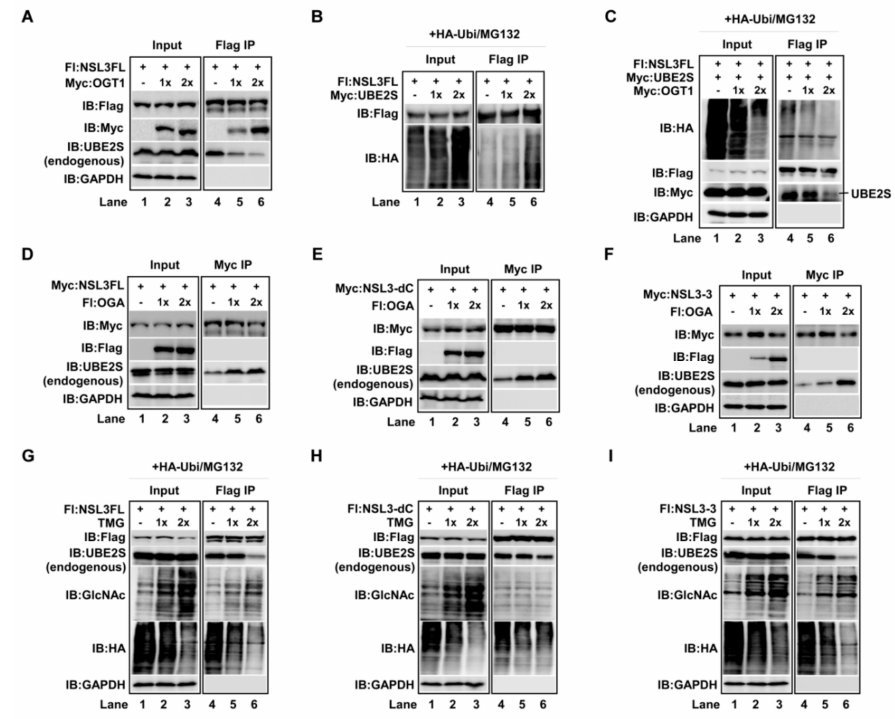
Figure 3. O -GlcNAcylation of NSL3 by OGT1 was tightly associated with UBE2S-mediated ubiquitin-degradation pathway. “ + , − ” in figures caption means with or without. ( A ) Dose-dependent inhibition of OGT1 on the interaction between endogenous UBE2S and NSL3: increasing amounts of Myc-OGT1 were co-transfected with Flag-NSL3 in 293T cells. Forty-eight hours after transfection, anti-Flag eluates were analyzed by WB with anti-UBE2S antibody. ( B ) Increased ubiquitin-degradation levels of NSL3 in the presence of UBE2S: degradation status of exogenous NSL3 was tested after Flag IP using anti-HA antibody. ( C ) Suppressed UBE2S-mediated degradation of NSL3 by OGT1: UBE2S mediated degradation of NSL3 was measured in Myc-OGT1 overexpressing cells. Simultaneously, the interaction between NSL3 and UBE2S was detected with anti-Myc antibody after Flag IP. ( D – F ) Dose-dependent increase of endogenous UBE2S bound to NSL3 by co-transfecting Flag-OGA with NSL3FL and its deletion mutants. ( G – I ) UBE2S-mediated degradation status of NSL3FL and its deletion mutants by TMG: 293T cells co-transfected with Flag-NSL3FL, NSL3-dC or NSL3-3 and HA-ubiquitin were treated with 0, 1, and 2 µ M TMG for 4h, then ubiquitin-mediated degradation of NSL3 was estimated by WB with anti-HA antibody and the O -GlcNAcylation level of NSL3 was estimated by WB with anti- O -GlcNAc antibody after Flag IP. The endogenous UBE2S protein levels were analyzed using WB with anti-UBE2S